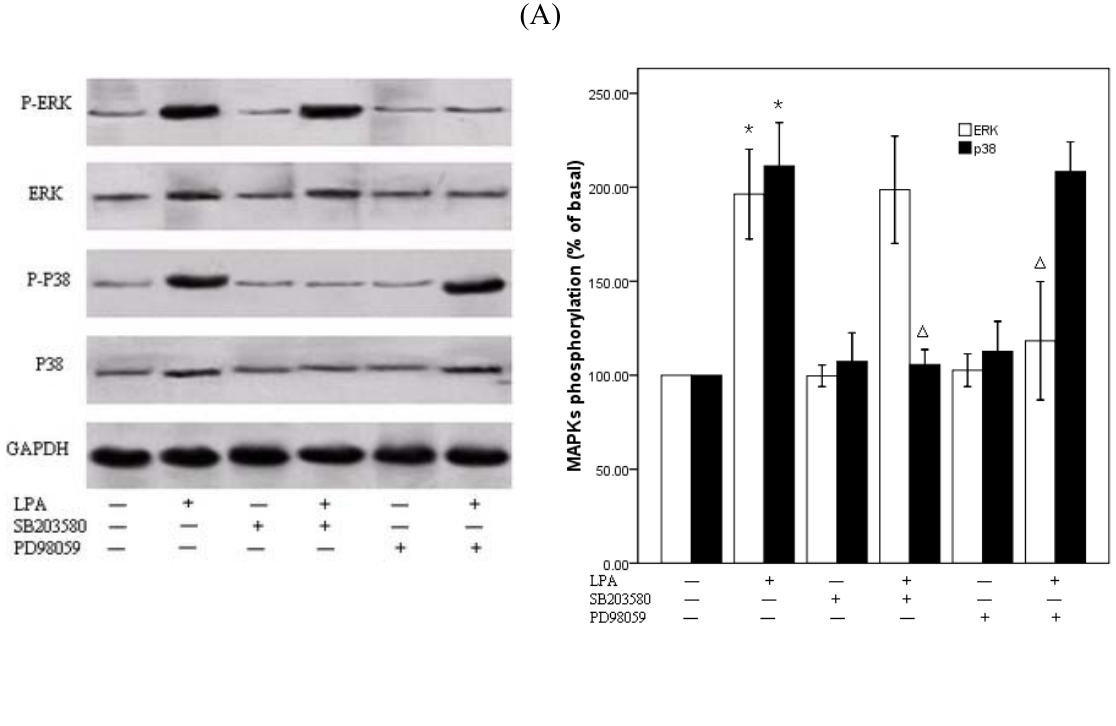
Figure 6. Effects of p38 and ERK inhibition on LPA-induced migration of